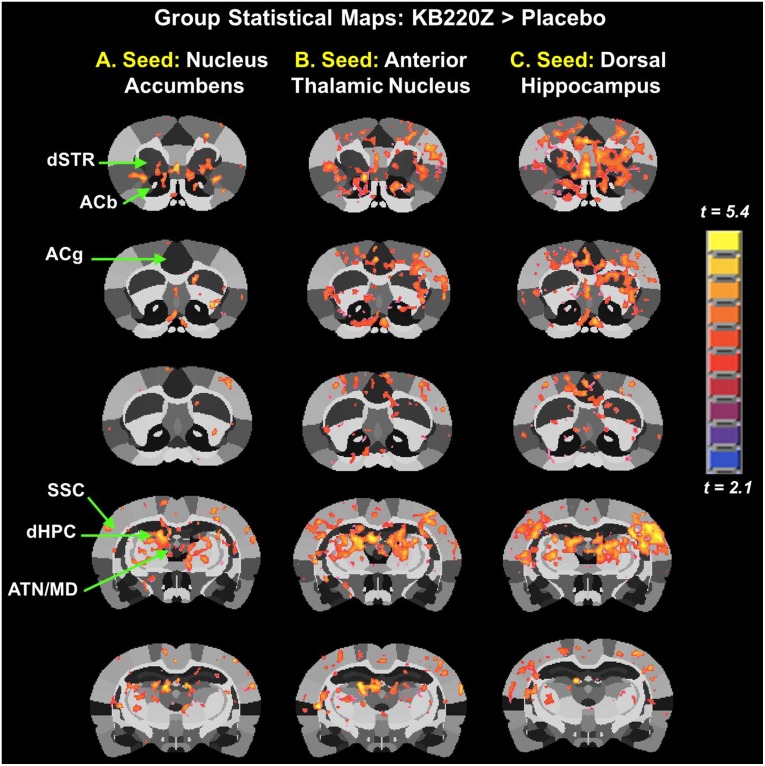
Group statistical maps comparing KB220Z and placebo treatments.Data are shown for three different seed regions: (A) accumbens (ACb), (B) anterior thalamic nucleus (ATN) and (C) dorsal hippocampus (dHPC), only left representations are shown here. Voxel-wise statistical t-tests (KB220Z vs. Placebo, p < 0.05, two tailed, heteroscedastic variances; cluster-size corrected using 3dClustSim on AFNI were used to compare the two groups. Other ROI indicated by green arrows are the dorsal striatum (dSTR), anterior cingulate (ACg), accumbens (ACb), somatosensory cortex (SSC); and the mediodorsal thalamus (ATN/MD).